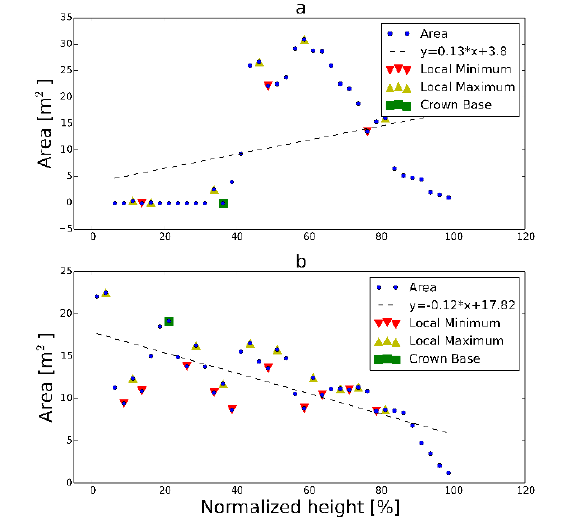
Figure 3. Derivation of the local extrema and the crown base, by differentiating two cases: a.) trees having a more rounded crown shape and b.) trees having a more conical crown